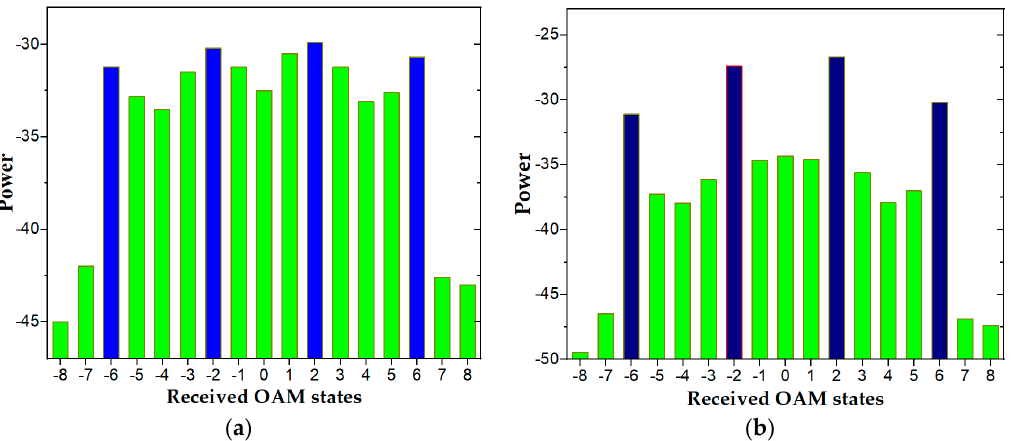
Figure 2. Power distributions of orbital angular momentum ( OAM) modes: ( a ) without AO assisted wavefront correction and ( b ) with AO assisted wavefront correction.